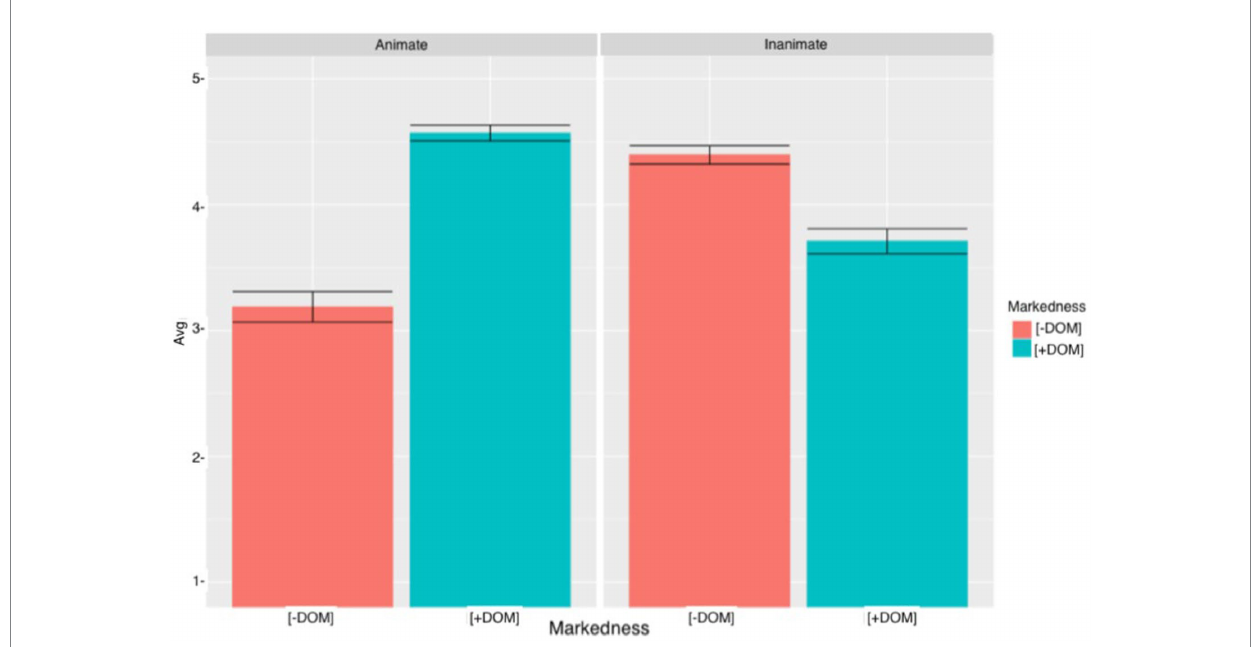
FIGURE 5 Heritage speakers’ mean acceptability scores and errors bars (95% CI) for SVO